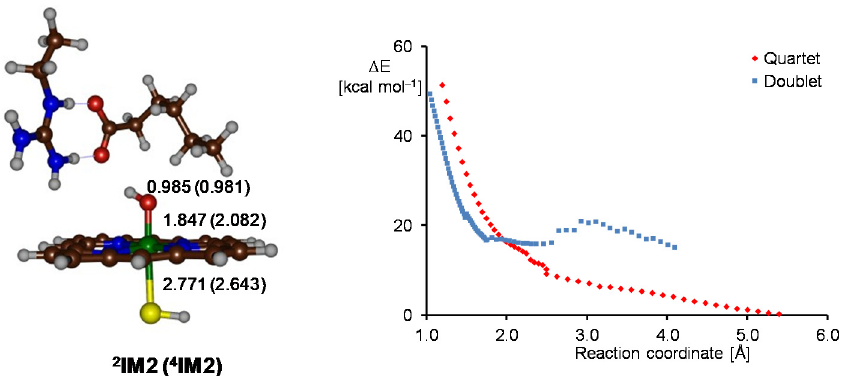
Figure 5. Optimized geometry of the iron(III)-hydroxo substrate complex of the catalytic cycle of P450 OleT JE with bond lengths in angstroms. Geometry scan for C β ‒ H hydrogen atom abstraction in the quartet and doublet spin states.